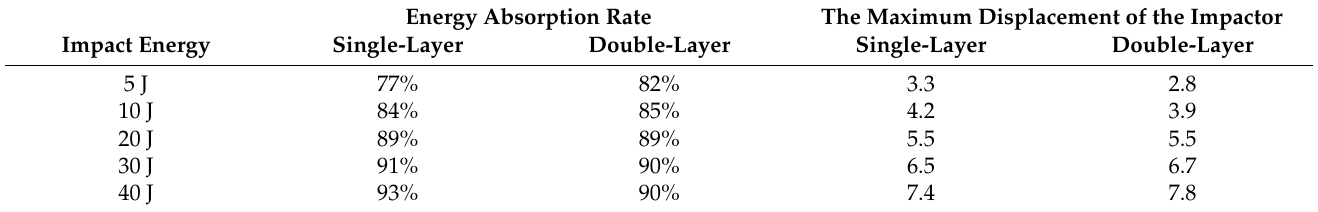
Figure 6. Contact force − Time curves of double-layer structure under 5 J to 40 J impact energies. Table 5. Impact responses of single-layer and double-layer structures under different impact